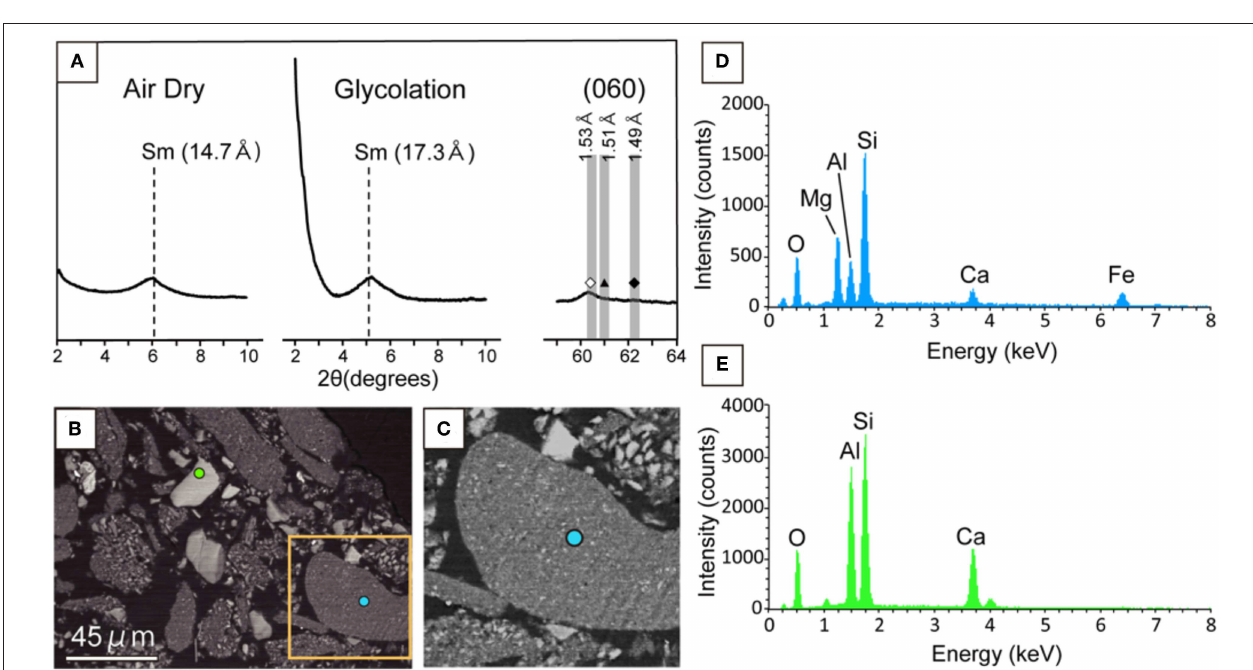
FIGURE 2 | Mineralogical characteristics of a fracture filled with calcium carbonate in U1365E-7R2. (A) Optical microscopic image of the fracture with a yellow rectangle indicating an enlarged area shown in (B) . (B) Back-scattered electron image of the fracture obtained by SEM. (C,D) EDS spectra with colors obtained from circles with the same colors in (B) .